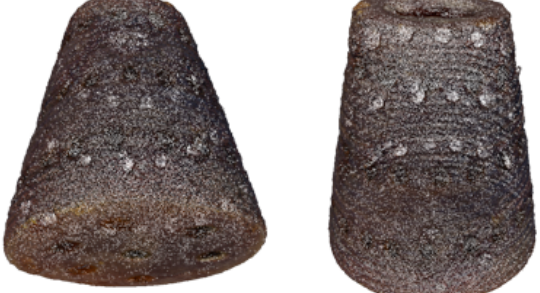
Figure 7. Point cloud of one of the processed objects based on 32 images, two datasets from the rotated